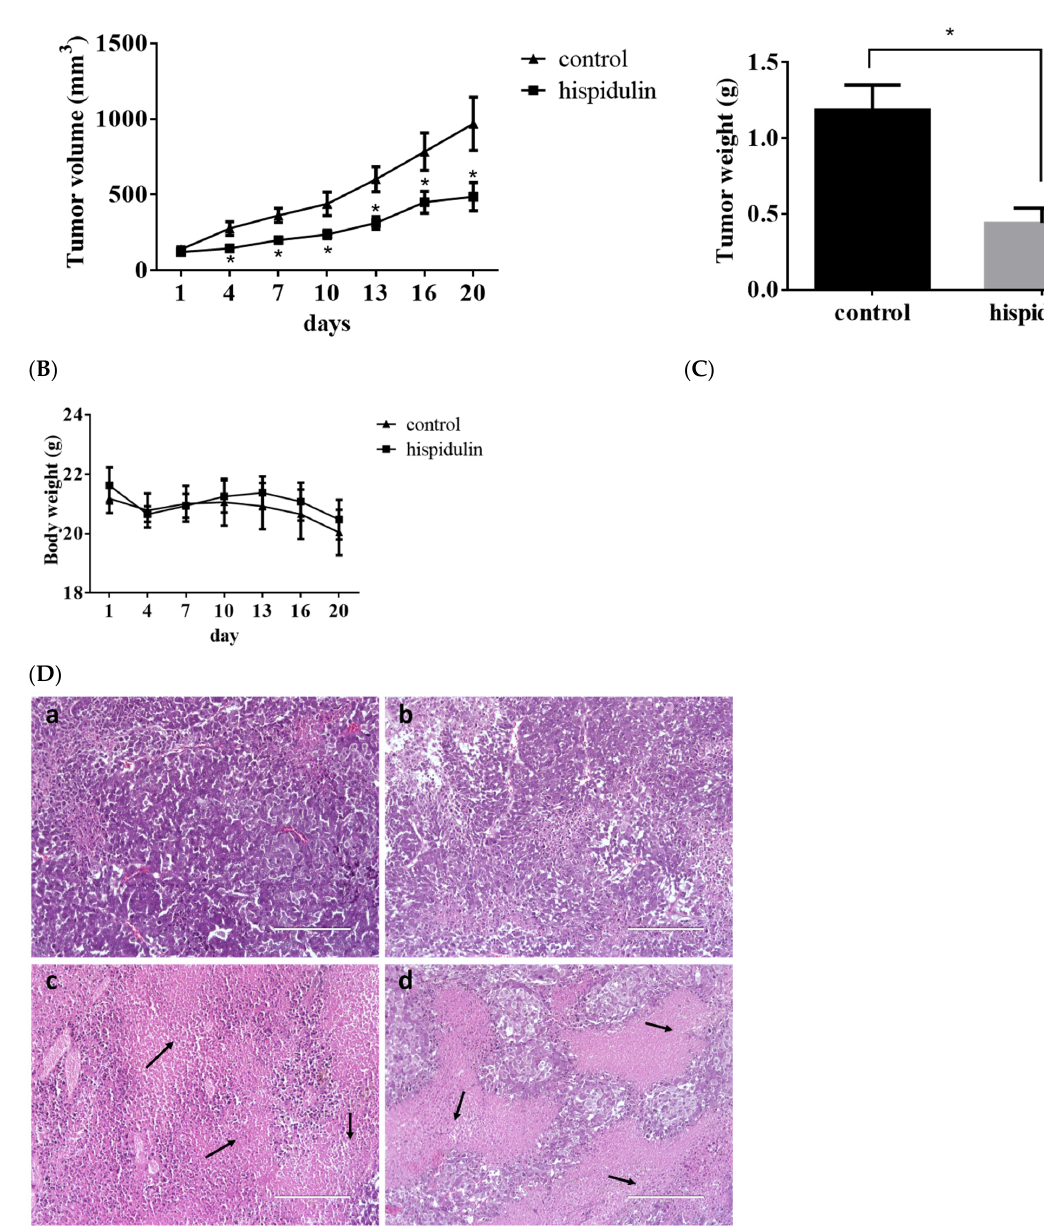
Figure 9. Hispidulin inhibited tumor growth in the xenograft model. A2058 cells inoculated subcutaneously into the nude mice. After a week, mice then received intraperitoneal (i.p.) injections of the vehicle (DMSO in PEG 400) or 40 mg/kg of hispidulin once per day for 19 consecutive days. On the 20th day, the mice were euthanized. ( A ) Representative mice with A2058 xenografts are shown at different time-points. Day 1 represented the first day of administration and mice were recorded every 3 days. ( B ) Time-dependent effect of hispidulin on melanoma growth in an A2058 xenograft mouse model. ( C ) Tumor weight measured at the endpoint and typical photographs. ( D ) Body weights at different time points. The data represent the mean ± SE, with * p < 0.05 compared with the control group (vehicle). ( E ) The H&E staining analyzed tumor tissue sections from the mice treated with ( a , b ) vehicle or ( c , d ) hispidulin (magnification, 200×) (n = 7 per group). Arrows indicate the large areas of tumor cell necrosis .